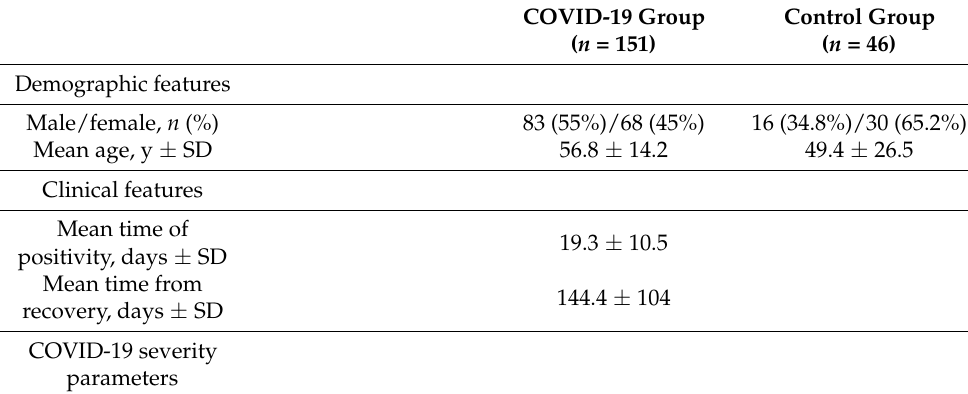
Table 1. Demographic and clinical characteristics of studied